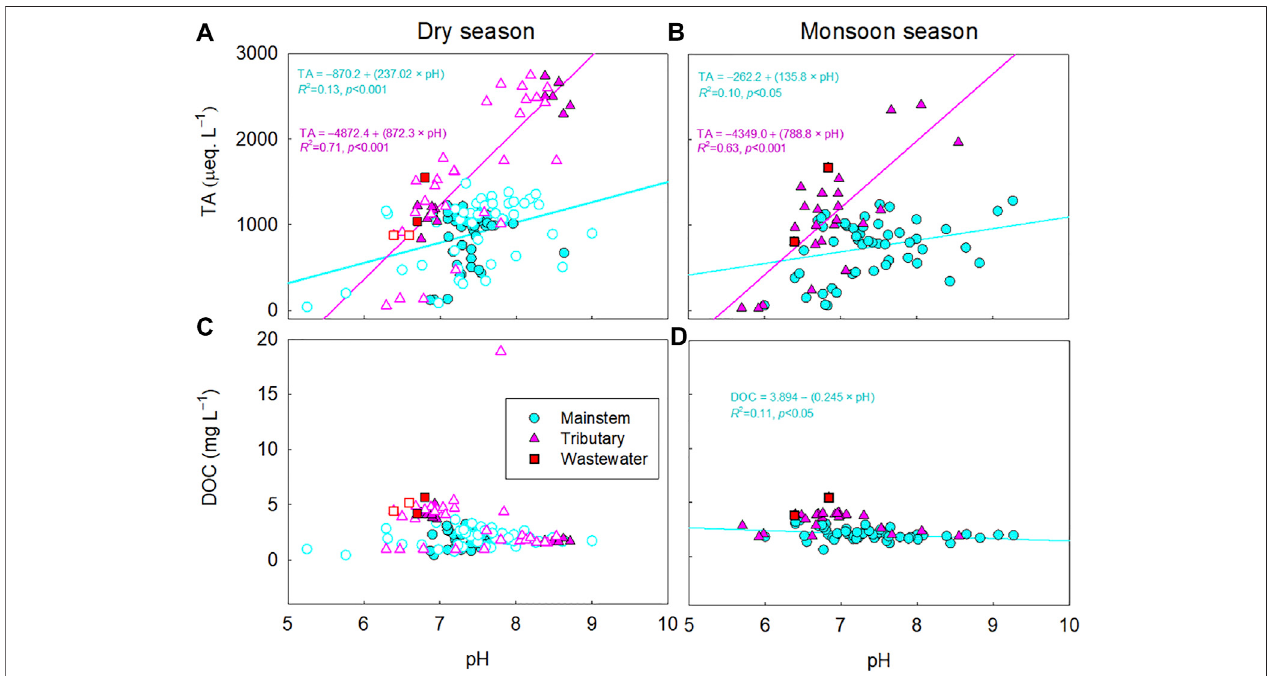
FIGURE 7 | Relationships between pH and total alkalinity (TA) (A,B) or dissolved organic carbon (DOC) (C,D) in the mainstems (M), tributaries (T), and wastewater ef fl uents (W) of the Han River during the monsoon and dry seasons. For the dry season, samples are indicated by fi lled symbols for the months without “ rainfall, ” while void symbols represent the months with “ sporadic rainfall. ” The signi fi cant relationship ( p < 0.05) is indicated by a regression line through the plot.